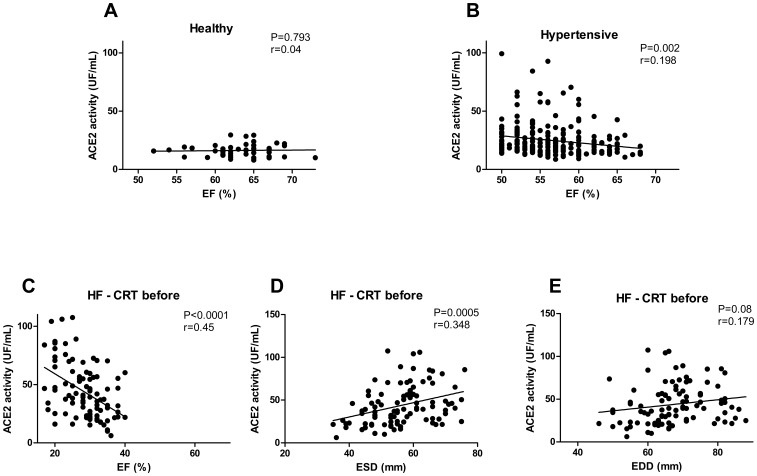
Serum ACE2 activity correlates with left ventricular ejection fraction.Serum ACE2 activities were plotted as a function of left ventricular ejection fraction (EF), in healthy people (healthy, n = 45, panel A), in patients with preserved EF (hypertensive, n = 239, panel B and in patients with severe reduction in EF (HF - CRT before, n = 65, panel C). Serum ACE2 activities were also plotted as the function of the cardiac morphological parameters end systolic diameter (ESD, panel D) and end diastolic diameter (EDD, panel E) in heart failure patients before CRT (HF – CRT before). Each dot represents values of individual patients. Points were fitted by linear regression. The value P indicates the level of significance of the positive correlation between the plotted parameters, while r represents a measure of the goodness of the fit.